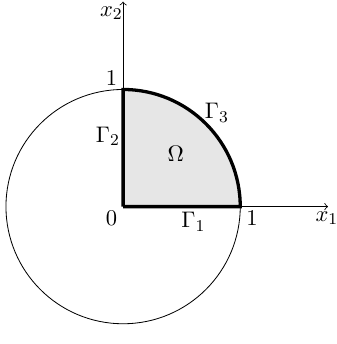
Figure 1. Computational domain